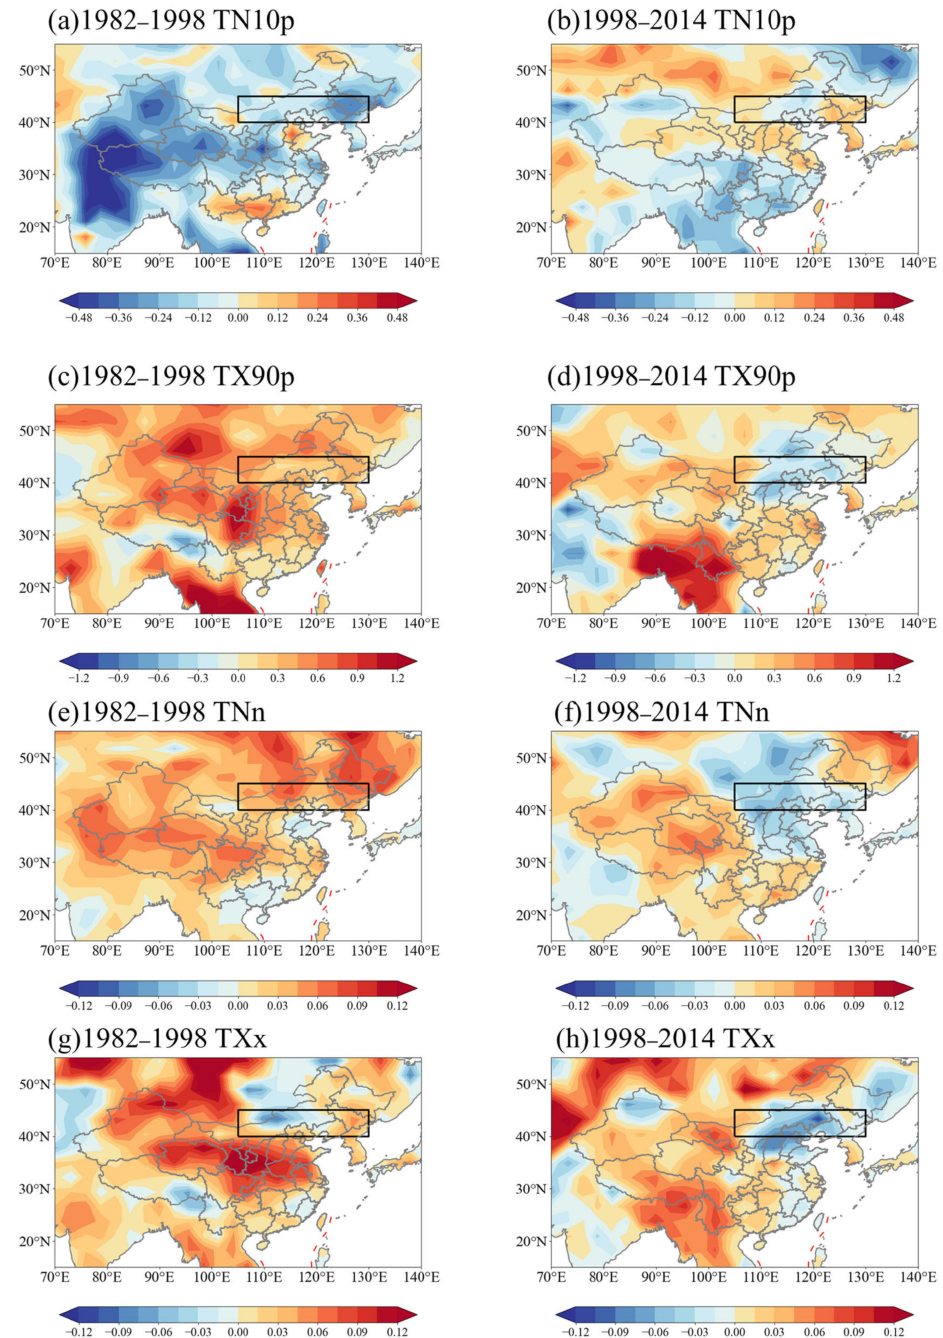
Figure 5. Trend analysis of four extreme indexes related to temperature for different periods. ( a , b ) Cold nights (TN10p) (%). ( c , d ) Warm days (TX90p) (%). ( e , f ) Annual minimum of daily minimum temperature (TNn) ( ◦ C). ( g , h ) Annual maximum of daily maximum temperature (TXx) ( ◦ C). Note: Warm tones represent an increasing trend, cool tones represent a decreasing trend. The red dashed lines in the figure represent Ten-dashed lines. The numbers below the description of the colors represent the trend slope value. The black box in it is defined as the northeastern region of East Asia (40~45 ◦ N, 105~130 ◦